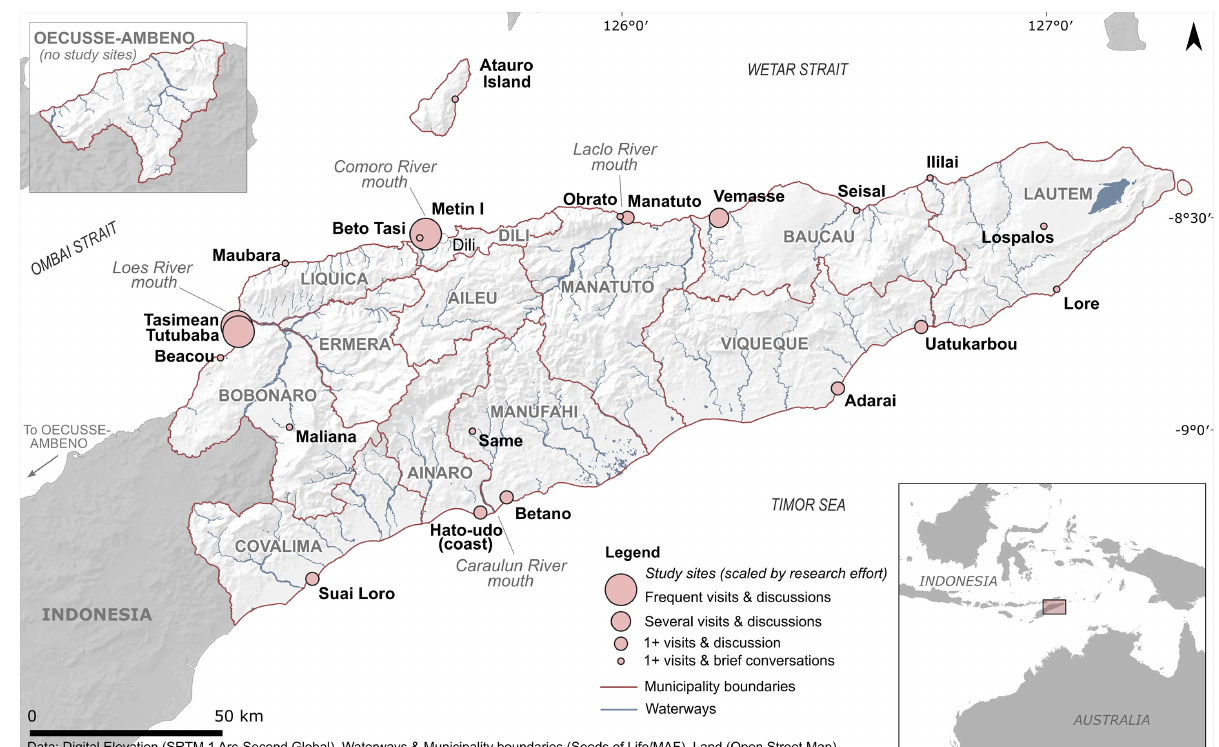
( Figure 1 , further details in Supplementary Table 1.1 ).